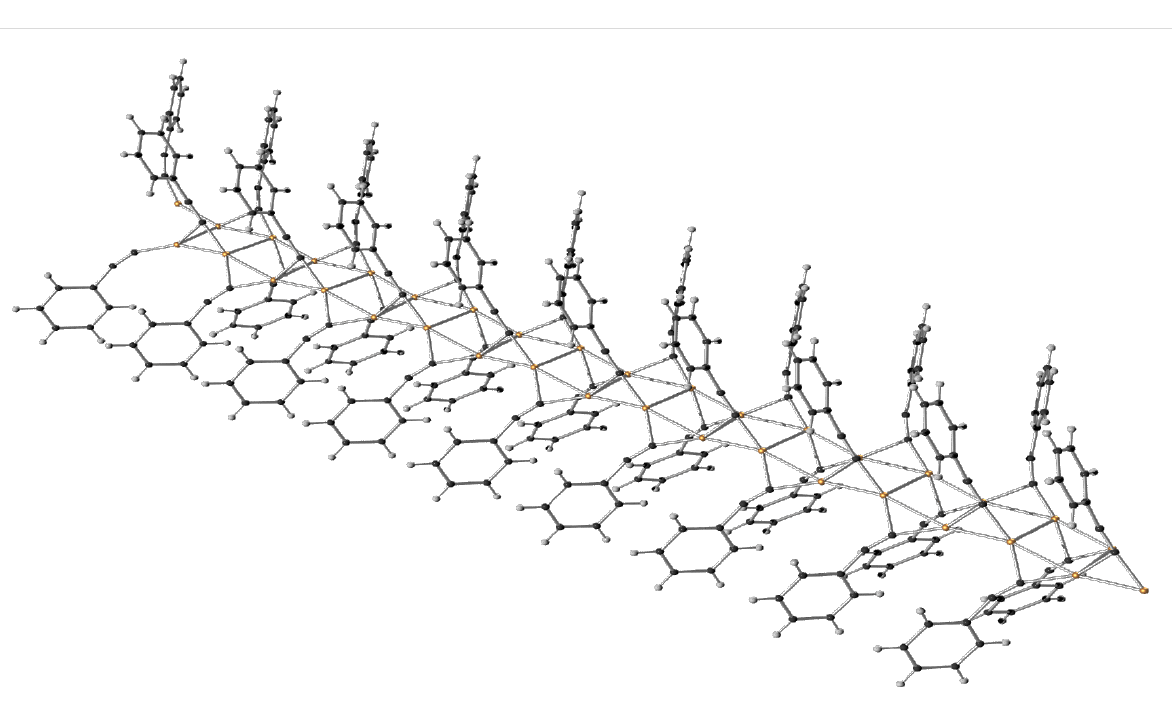
The distance between the two copper(I) ions was found to be between 2.49 and 2.83 Å. The group of Heaney recognized that this intermetallic distance was in the same range as calculated by Ahlquist and Fokin for the transition state in CuAAC reac- tions featuring dinuclear model structures (2.54 Å and 2.64